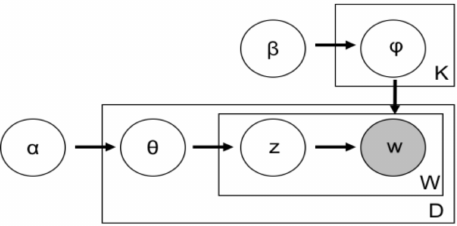
Figure 3. Graphic model of Latent Dirichlet Allocation ( K : Topics, W : Word Vocabulary, D : Document; adapted from Porteous et al.